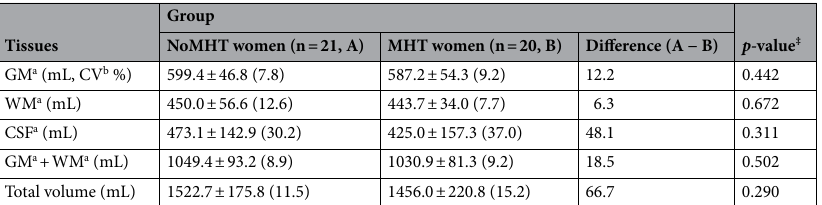
Figure 3 shows the correlation between cer- ebral volumes and MHT treatment. MHT women showed positive correlations between the treatment period and the volumes of the AnG (Spearman’s rho, ρ = 0.588; p = 0.006), and the treatment period and the volumes of the Hy (ρ = 0.465; p = 0.039), respectively. Meanwhile, MHT women showed negative correlations between FSH levels and the volumes of the Hy (ρ = − 0.549; p = 0.012), luteinizing hormone (LH) levels and the volumes of the Hy (ρ = − 0.503; p = 0.024), and the progesterone (PG) levels and the volumes of the IFG (ρ = − 0.476; p = 0.034) and the PG levels and the volumes of the AnG (ρ = − 0.487; p = 0.029).